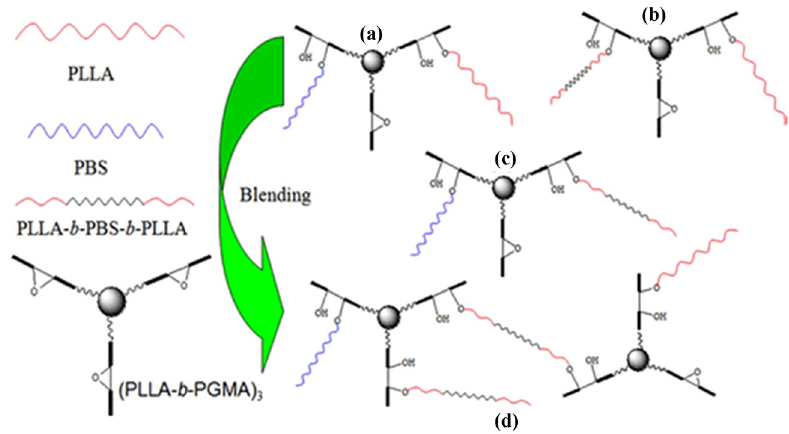
Figure 6: Schematic of the in situ reactive blending of PBS - PLLA, PLLA, and PBS in the melt in the presence of ( PLLA - b - PGMA ) 3 ( 63 ) . Copyright 2017. Reproduced with permission from American Chemical